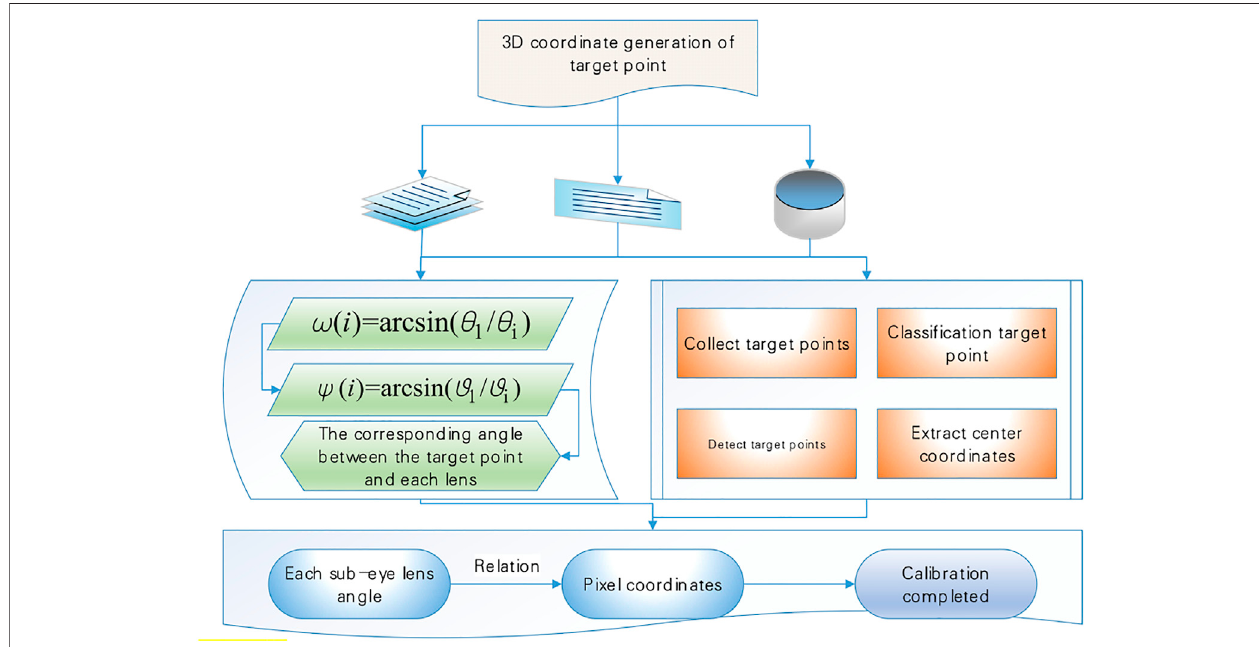
FIGURE 2 | Calibration of Curved Variable Focal Length compound eye imaging